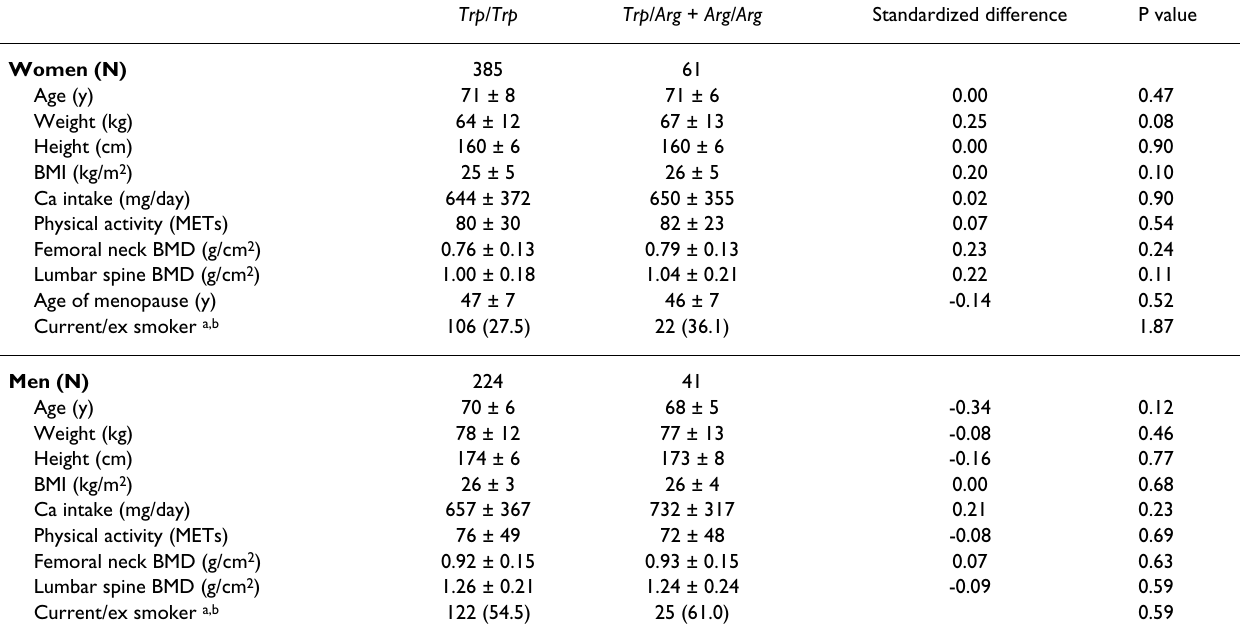
Table 1: Baseline characteristics of subjects stratified by ADRB3